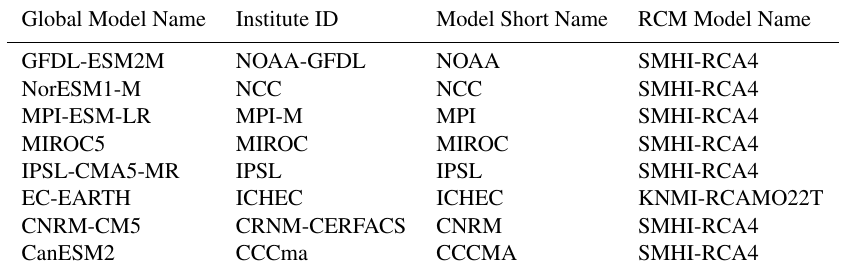
Table 1. Used climatic models, global model under which they are run (column 1), their Institute of origin (column 2), their short name (column 3) and RCM model Name (column 4).